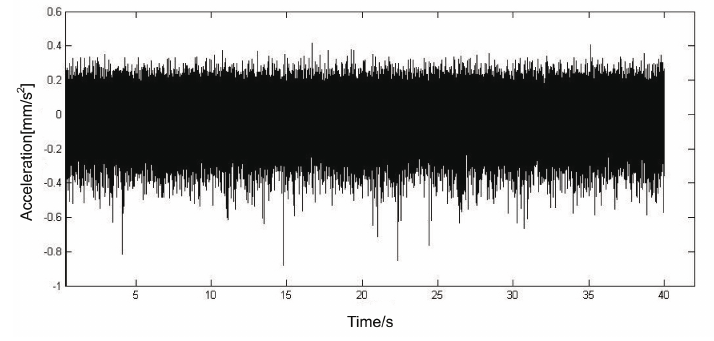
Figure 8. A time domain waveform on shaft